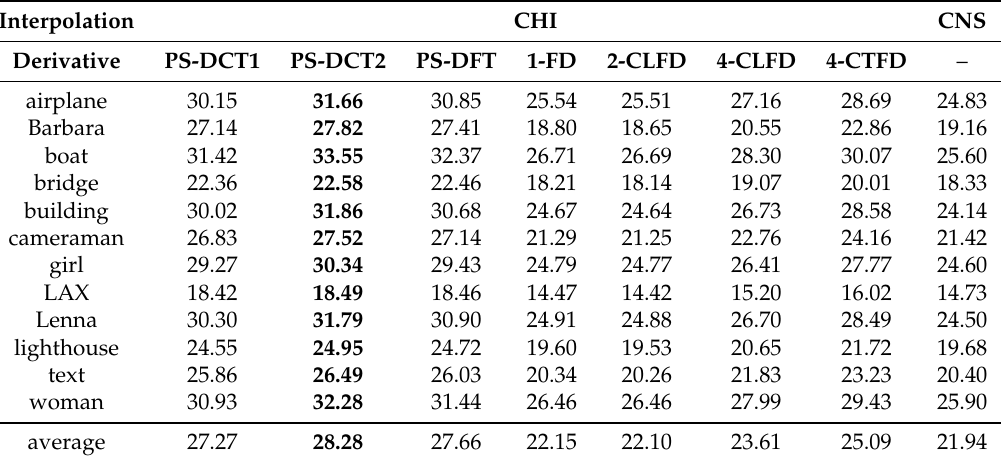
Table 3. SNRs (dB) of the final output after successive image rotation.